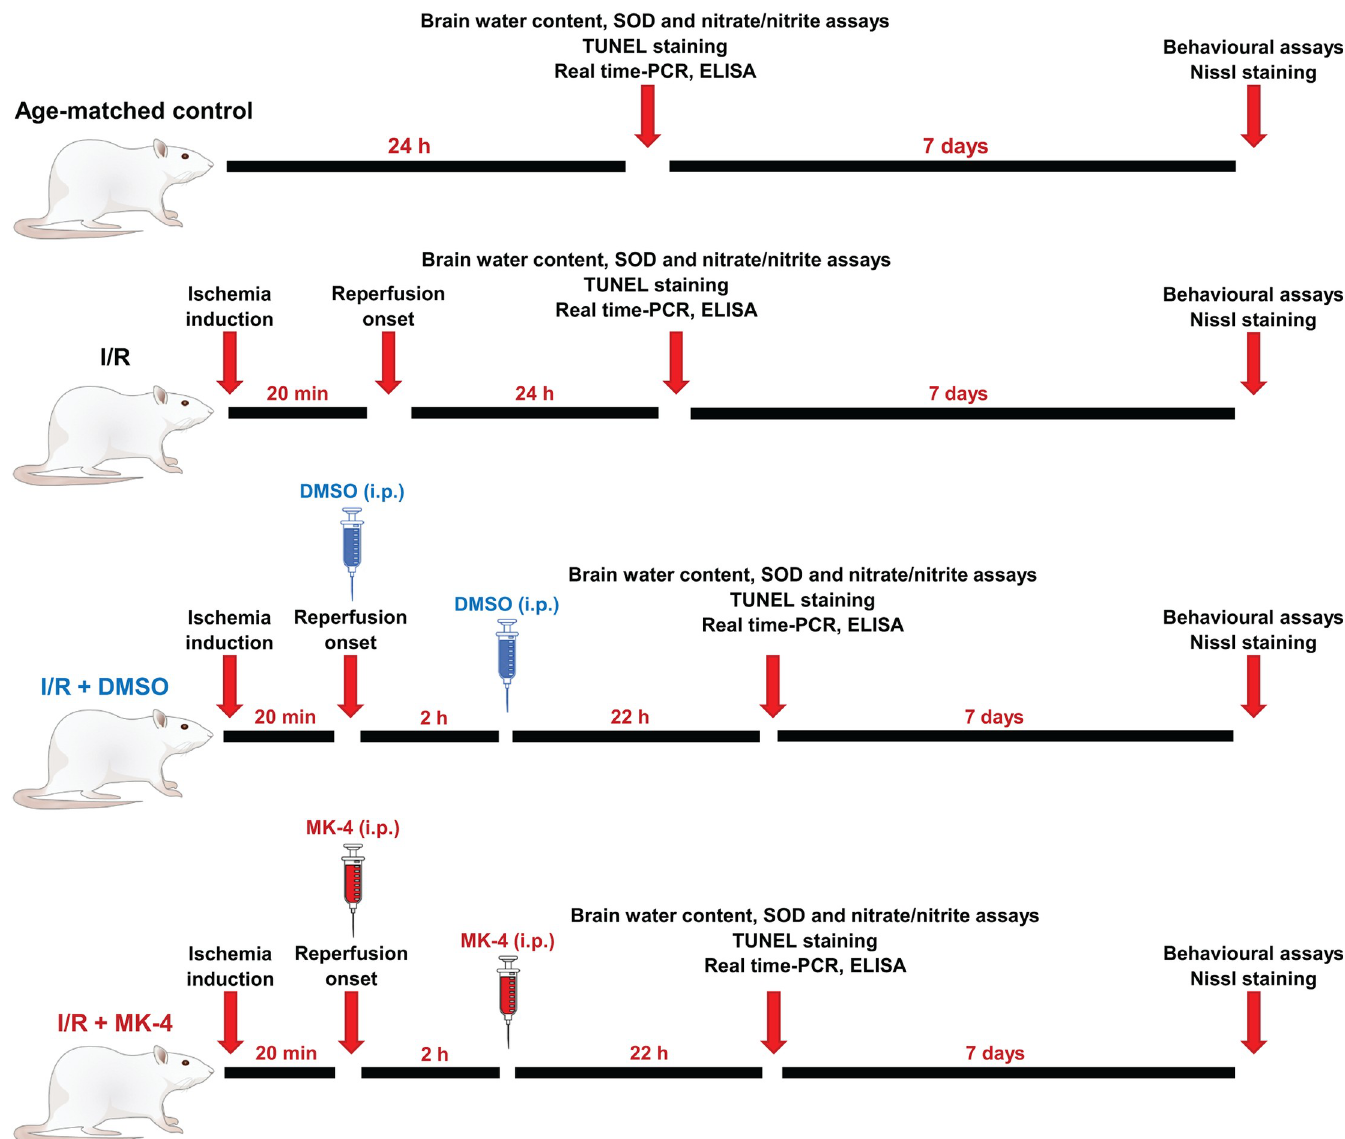
Fig 1. A schematic experimental timeline (N = 5–6 for each